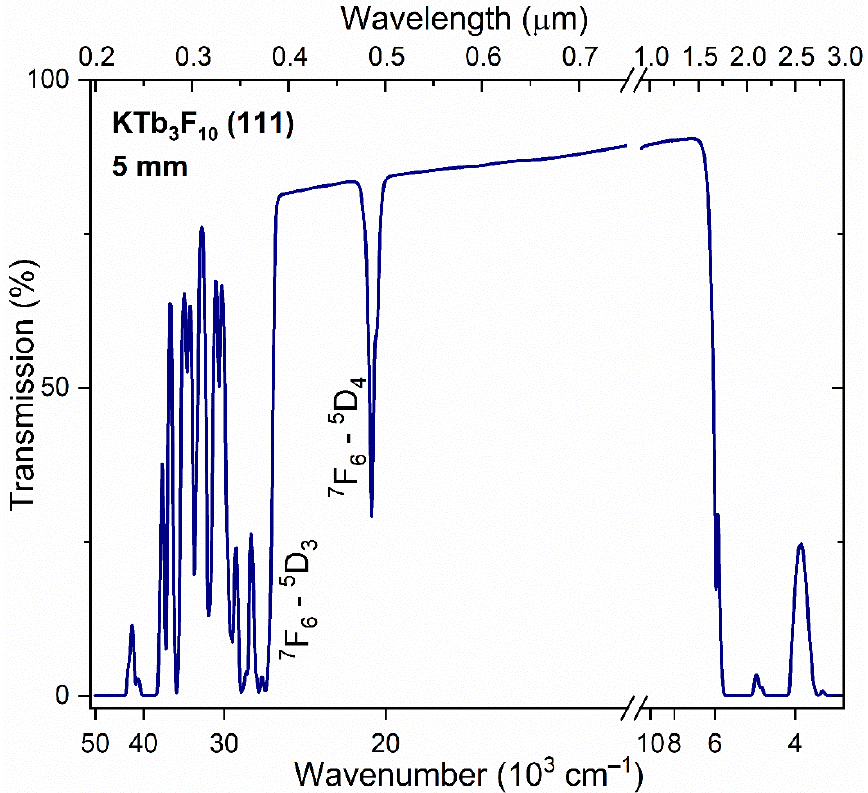
Figure 2. RT transmission spectrum of the KTF crystal.